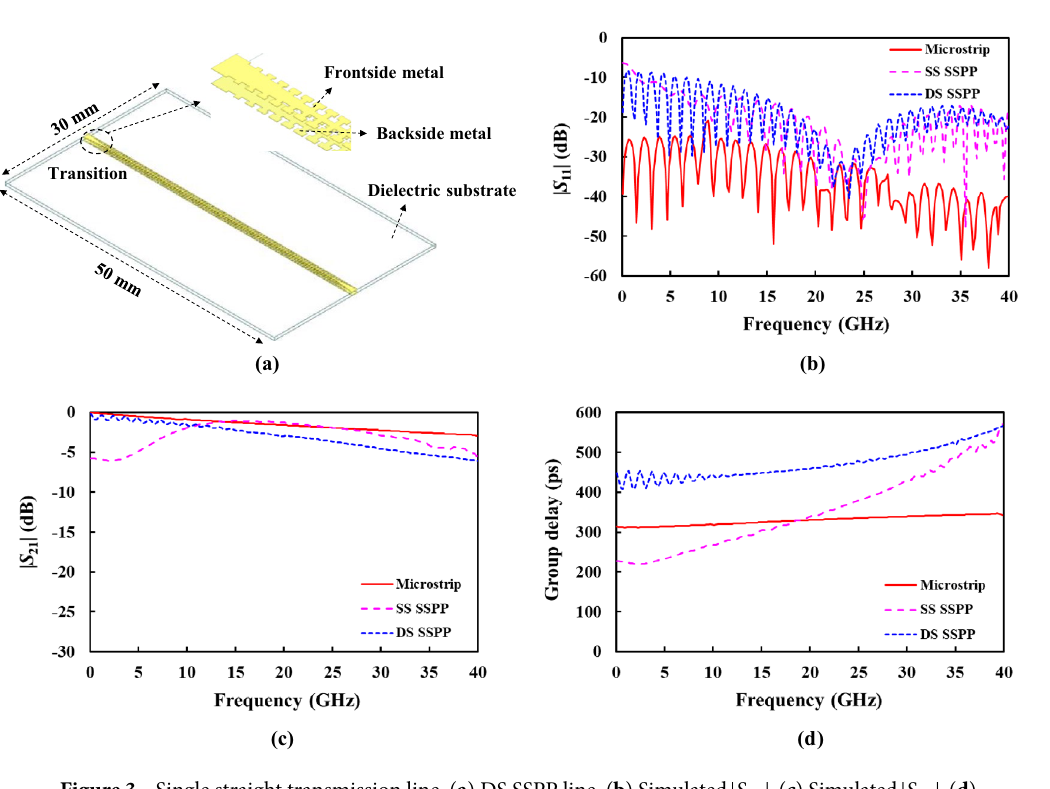
Figure 3. Single straight transmission line. ( a ) DS SSPP line. ( b ) Simulated | S 11 | . ( c ) Simulated | S 21 | . ( d ) Simulated group velocity.